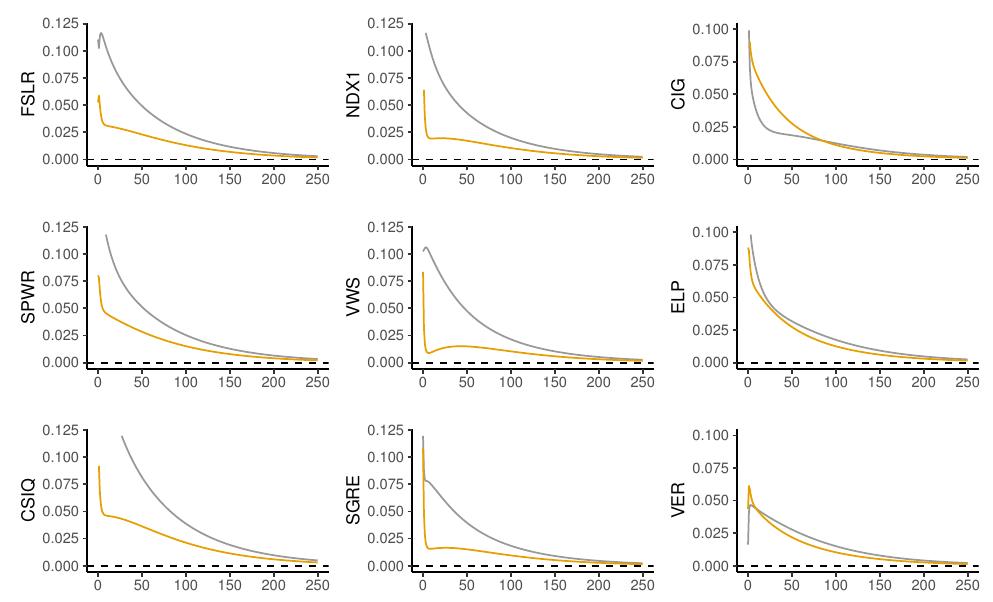
Figure 4. Impulse–response analysis of clean energy stocks, clustered by sector of production, when faced with a shock in GVZ (gray line) and in OVX (orange line) one year ahead (250 days). Left, center, and right columns correspond to solar, wind, and hydroelectric energy companies, respectively.